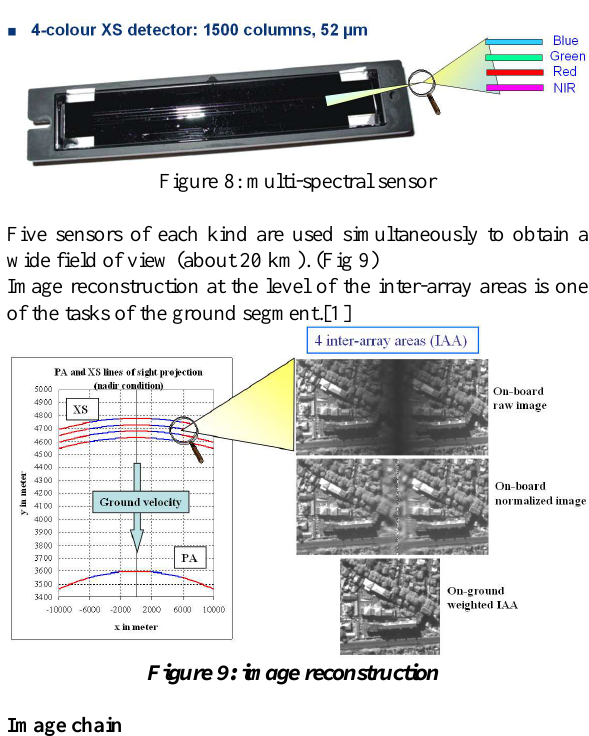
Figure 7: panchromatic TDI sensor The multi-spectral detection channel is realized with 5 sensors of 1500 pixels per line each, with a pixel size of 52 µm (Fig 8). Each sensor consists in a four lines assembly, enabling four colors imaging (blue, green, red, near infrared). Interferometric filters directly stuck down on the detector glass window provide coloring of these four channels.